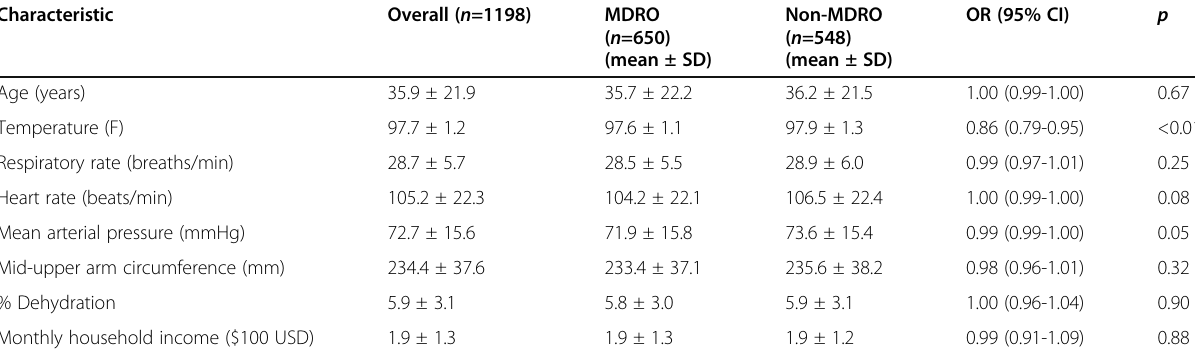
Abbreviations: OR odds ratio, CI confidence interval, F